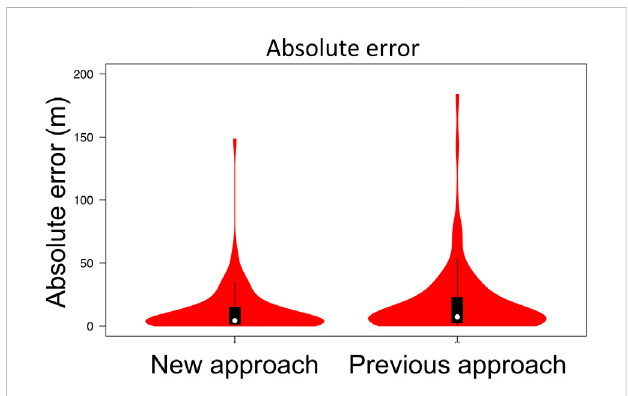
FIGURE 14 Absoluteerrorbetweenmeasurementsandcomputedpiezometric headsinsteadystatewiththeNAandPAapproaches.Whitecirclesshow the medians, box limits indicate the 25th and 75th percentiles as determined by R software, whiskers extend 1.5 times the interquartile range from the 25th and 75th percentiles and polygons represent density estimates of data and extend to extreme values.